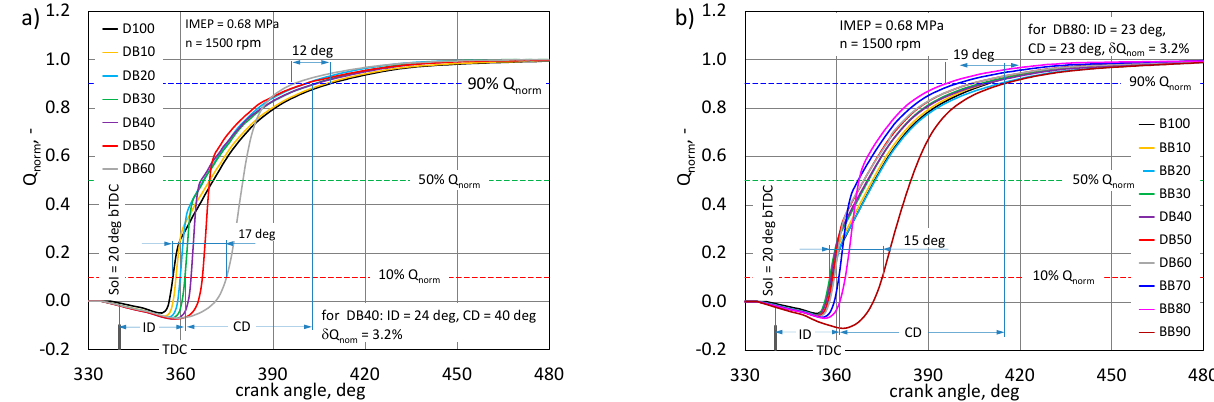
14 of 30 on HRR traces. For the BB ‐ powered engine, the HRR gain was only 25 J/deg. RME, thanks to its properties and good miscibility with n ‐ butanol, gives great possibilities for co ‐ com ‐ bustion with alcohols, especially with higher alcohols [20,22,38]. In the work [28], a similar effect of butanol share on the nature of heat release rate was observed. The increase in the share of butanol resulted in an increase in the HRR max value. An important aspect of the assessment of the combustion process in a reciprocating engine is the analysis of its char ‐ acteristic stages: ignition delay (CA10) and duration of combustion (CA90), as well as the assessment of the crank angle after the TDC for which 50% heat release (CA50) occur. These characteristic combustion stages are determined on the basis of the normalized heat release (Q norm ) [27,45]. The first stage of combustion is the ignition delay, defined as the time (usually expressed in degrees of CA) from the start of injection to the moment when 10% of heat is released. It is assumed that at this stage the flame front is already so devel ‐ oped that it quickly penetrates into the combustion chamber. The ignition delay time is Influenced by many factors, both physical and chemical [22,46]. Consequently, the igni ‐ tion delay period is often divided into physical and chemical retardation. Both steps usu ‐ ally occur simultaneously. The physical delay is mainly influenced by the injection pro ‐ cess, namely the angle of the jet and its range in the combustion chamber, the ability of the jet to atomize, vaporize the fuel, and mix with air within the flammability limits [22]. This feature can be indirectly observed in the course of the heat release rate. In the engine, where this phenomenon occurs intensively, the HRR waveform shows a large share of the